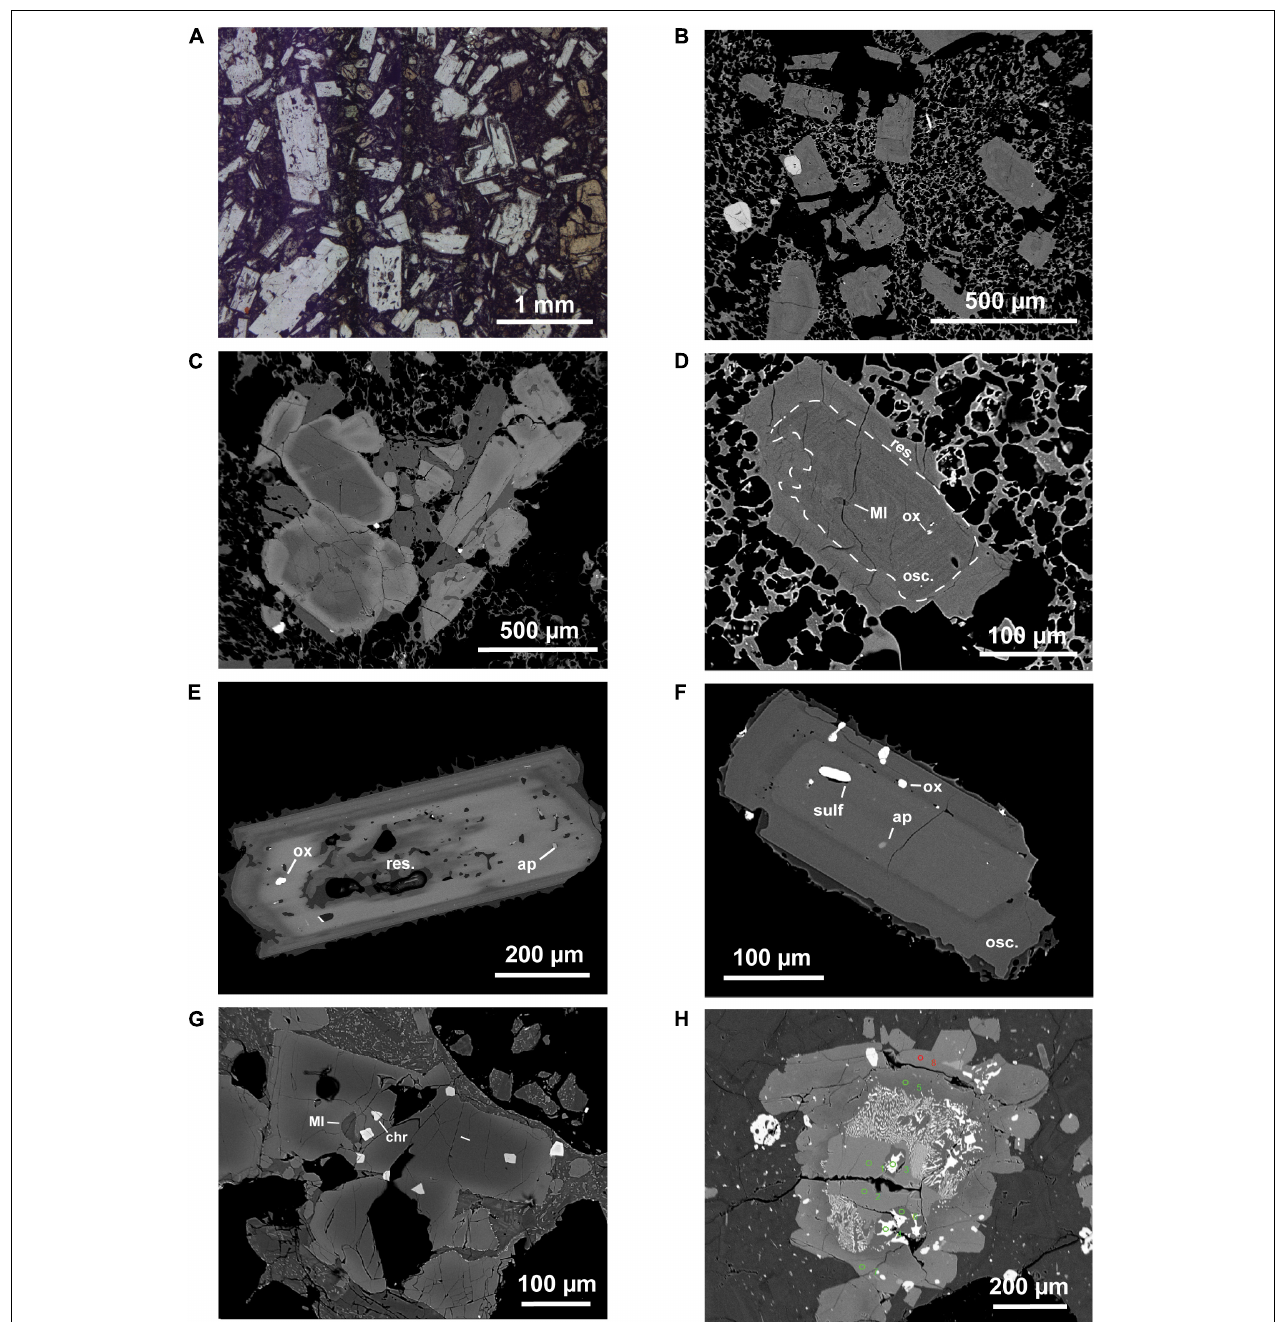
FIGURE 2 | Overview of typical textures of PVC lavas and pumices. (A) Plane-polarized light photomicrograph of Nealticán lava POP-80, showing plagioclase and pyroxene philocrysts with various disequilibrium features. (B) Back-scattered electron (BSE) image of Yellow Pumice (YP) sample POP-113, with zoned and variably resorbed plagioclase and minor pyroxene philocrysts in a vesiculated groundmass. (C) BSE image of an orthopyroxene – clinopyroxene glomerocryst with minor plagioclase and an interstitial groundmass of plagioclase, apatite Fe-Ti-oxides and glass. Sample POP-112 (Pink Pumice, PP). (D) BSE image of an oscillatory (osc.) zoned plagioclase core with melt (MI) and oxide (ox) inclusion, resorbed (res.) by a surrounding band of distinct composition. Sample POP-113 (YP). (E) BSE image of a partially resorbed (res.) orthopyroxene core with apatite(ap) and Fe-Ti-oxide (ox) inclusions, surrounded by several bands with reverse and normal zoning patterns. Sample POP-112 (PP). (F) BSE image of a rounded clinopyroxene core with sulfide (sulf) and apatite (ap) inclusions surrounded by a darker, Fe-Ti oxide (ox) bearing band and a resorptive, oscillatory rim (osc.). Sample POP-64 (PP). (G) BSE image of pristine olivine showing square or triangular chromite-inclusions (chr). Diffusive replacement along the crystal surface and surrounding a melt inclusion (MI) in the core is ongoing. Sample POP-25 (Chipiquixtle). (H) BSE image of remnants of an olivine crystal, largely replaced by vermicular intergrowth of orthopyroxene and Fe-Ti-oxides, and further overgrown by subhedral orthopyroxene. Sample POP-101